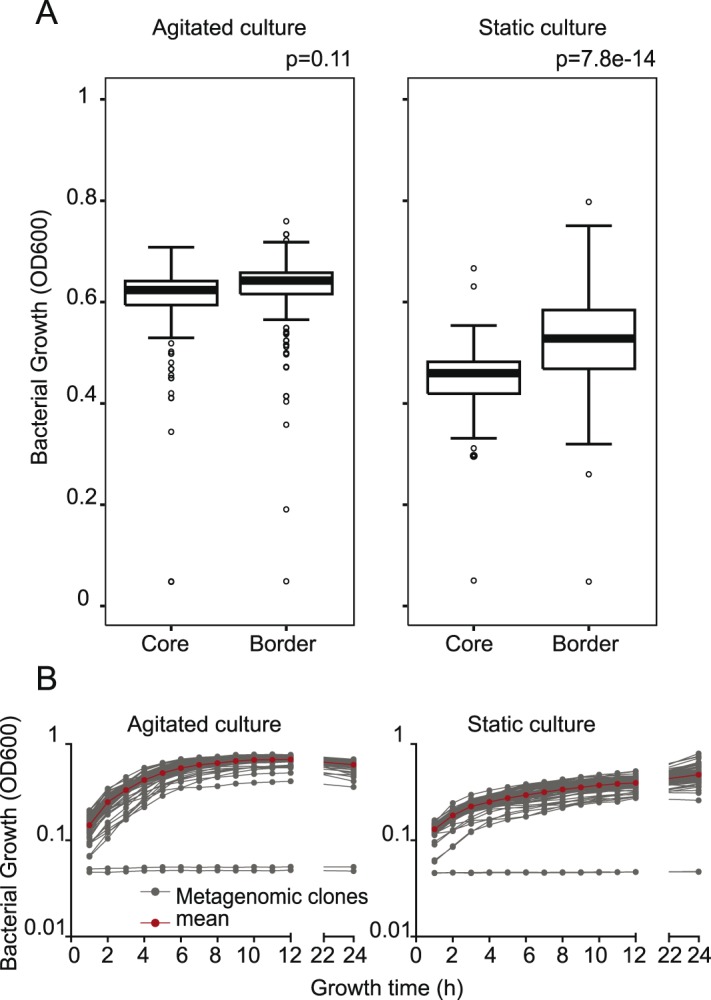
Metagenomic clones growth optimization.Four random plates of EPI300 metagenomic clones were inoculated from their −80°C glycerol stock into 96 well-plates (10% v/v) using a pipetting robotic workstation. After a 24 h pre-culture, they were re-inoculated and cultured overnight (10% v/v) at 37°C. These steps were performed either in static or agitated (700 rpm) culture conditions. Bacterial growth was monitored by optical density (OD 600 nm). A. Border and core wells of bacterial cultures in agitated (left panel) or static culture-conditions (right panel) for thus representative set of 4 plates. p-values indicated on the figure are the result of a unpaired t-test of the core versus border bacterial culture ODs. B. Growth curves of one representative plate of metagenomic clones (OD 600 nm) for agitated and static culture conditions. Red dots: mean OD600, joined grey dots: growth curve of single metagenomic clones.